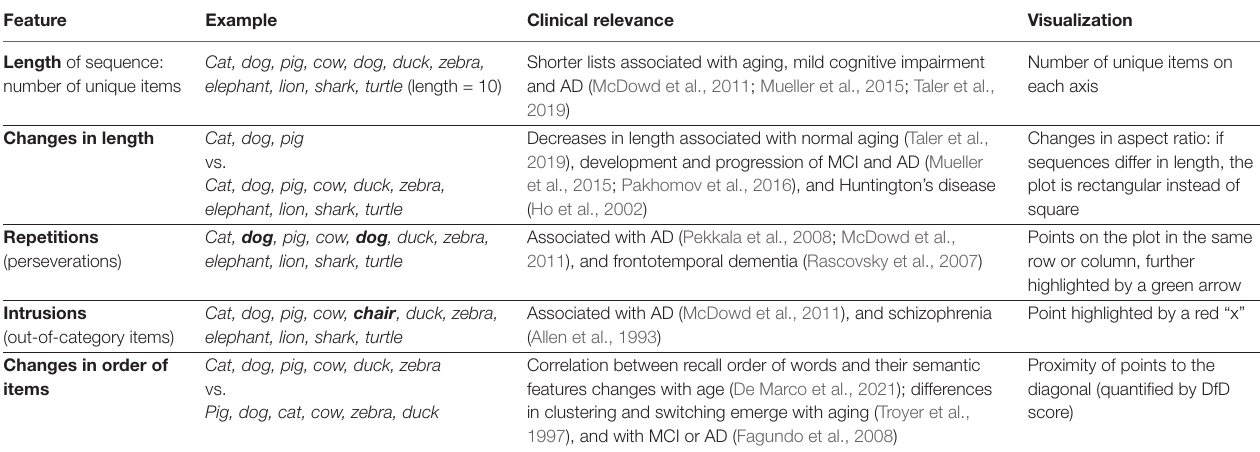
TABLE 1 | Clinically relevant features of semantic fluency data, and their incorporation into our visualization method.